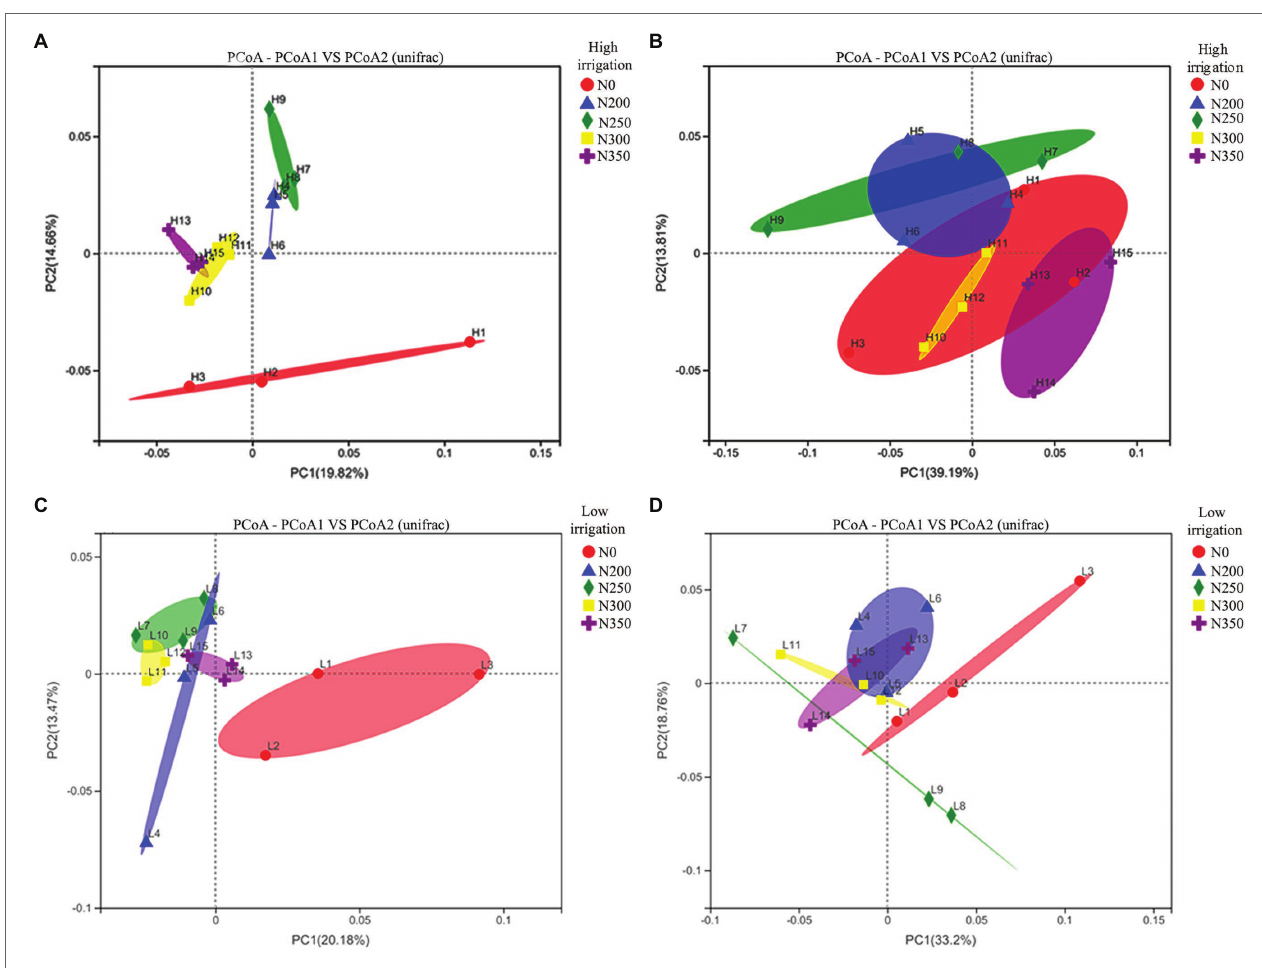
FIGURE 2 | Principal coordinate analyses (PCoAs) using unweighted UniFrac metric (A,C) and weighted UniFrac metric (B,D) indicate that the largest separation between bacterial communities is spatial distribution of irrigation water (PCo1) and the second largest source of variation is nitrogen fertilizer